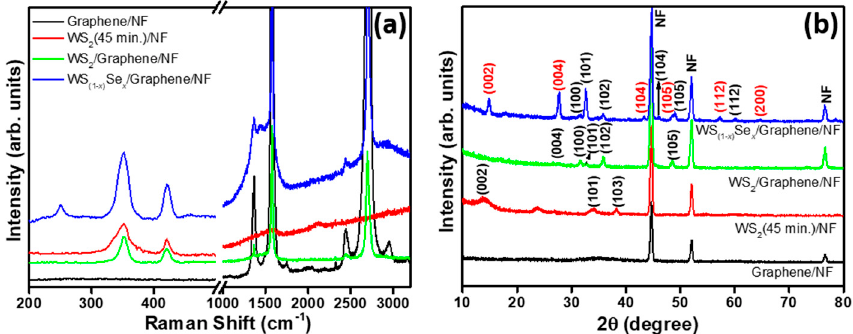
Figure 4. ( a ) Raman and ( b ) XRD spectra of graphene/NF, WS 2 (45 min)/NF, WS 2 /graphene/NF and WS (1 − x ) Se x /graphene/NF.